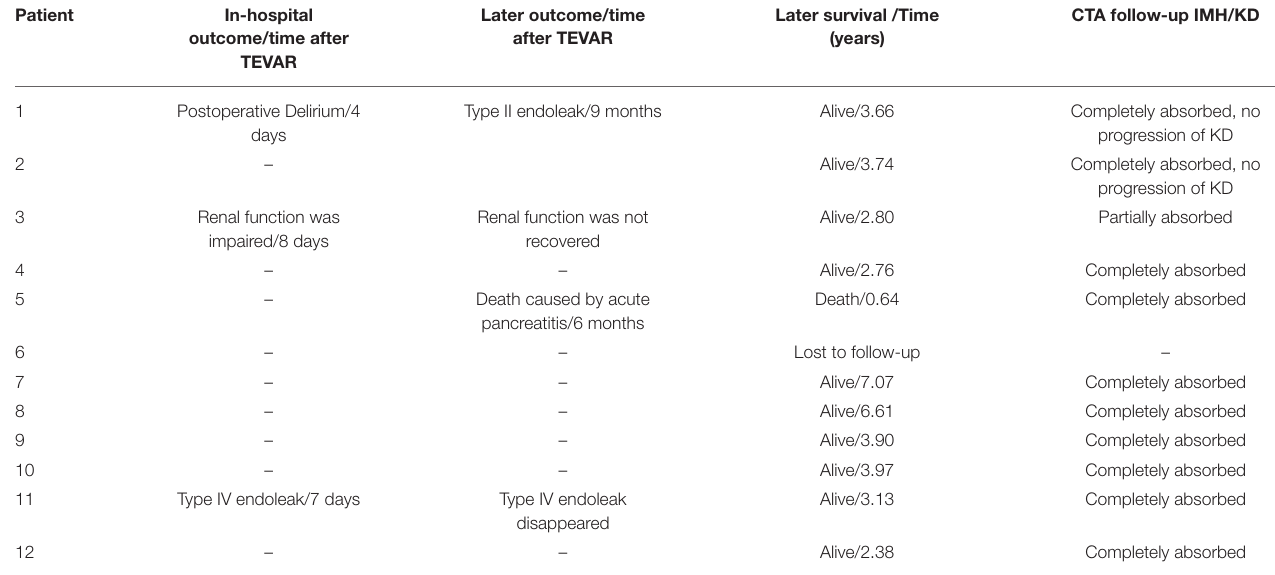
TABLE 4 | In-hospital and follow-up outcomes.